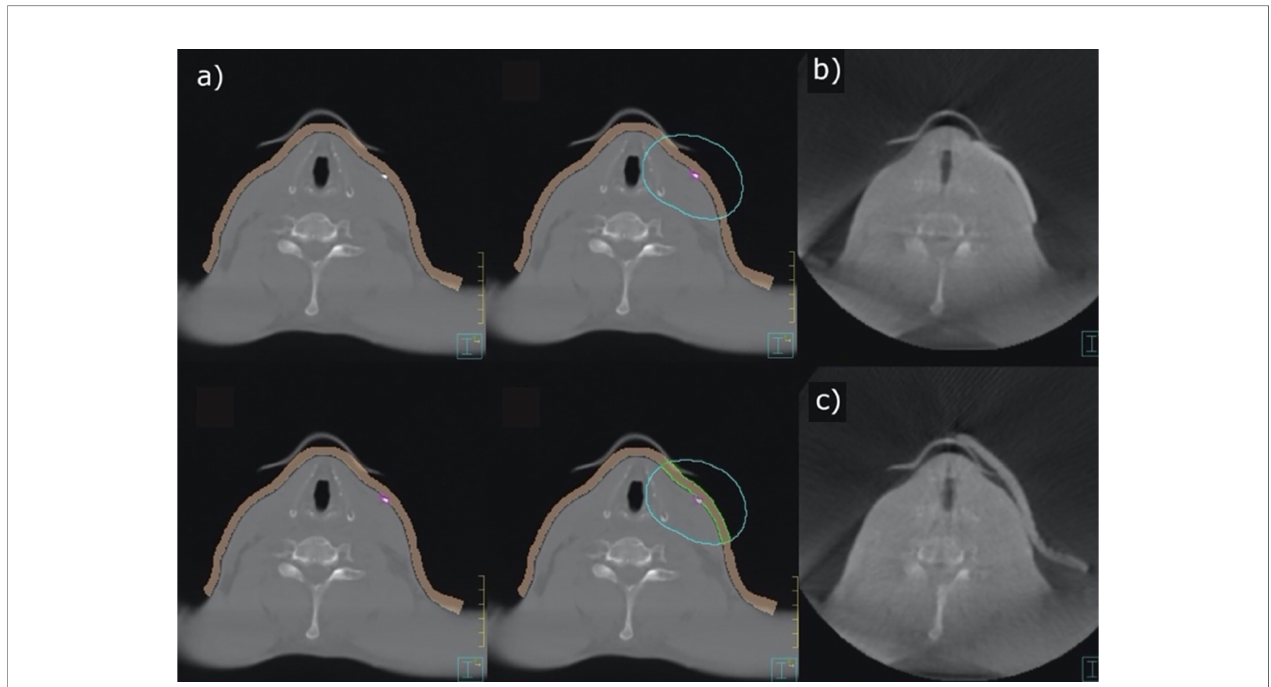
FIGURE 2 | Contouring of an individual bolus (A) , 3D-conformal bolus (B) , and commercially available bolus (C)